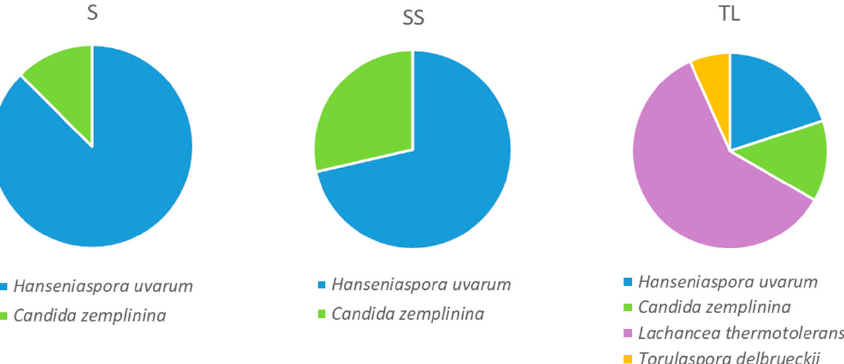
Figure 3. Proportion of yeast species at 24 h after vatting in the in the different inoculation strategies (SS: spontaneous sulfite, S: spontaneous without SO 2 , TL: inoculation with T. delbrueckii / L. thermotolerans at vatting without SO 2 ).